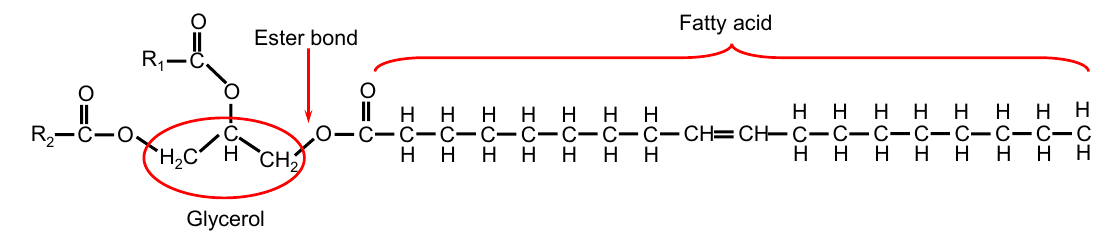
Figure 2. Postulated structure of bio-oil.